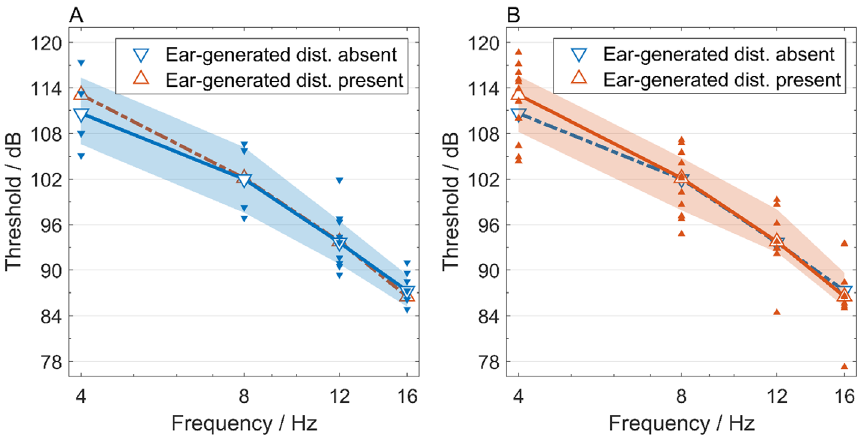
Figure 7. Sound pressure levels at threshold for pure-tone infrasound stimuli. The threshold data of the 16 listeners were separated according to the absence (blue, downward-pointing triangles) and presence (red, upward-pointing triangles) of ear-generated distortion products at any higher harmonic from f 2 to f 9 of the signal frequency f 1 . Open triangles indicate the median thresholds for the two groups of listeners. Semi-transparent areas indicate the corresponding inter-quartile ranges for those with distortion products (Panel B) and those without (Panel A).